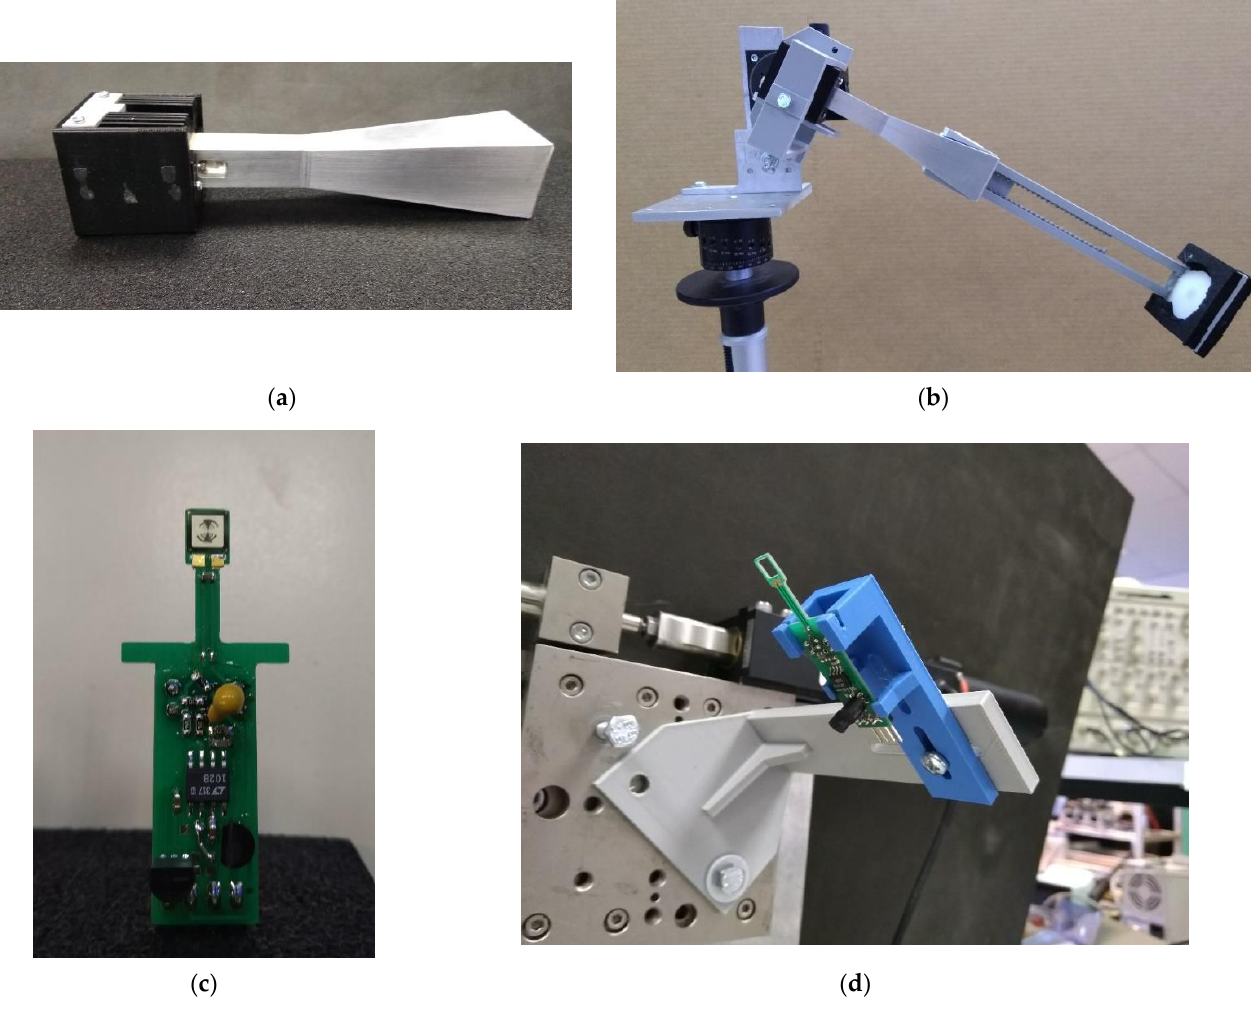
Figure 3. Schematic diagram of the experimental setup.